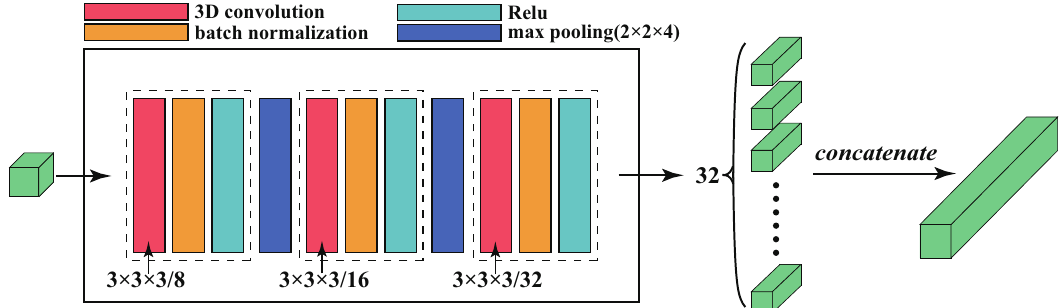
Figure 4. Visual representation of the feature learning